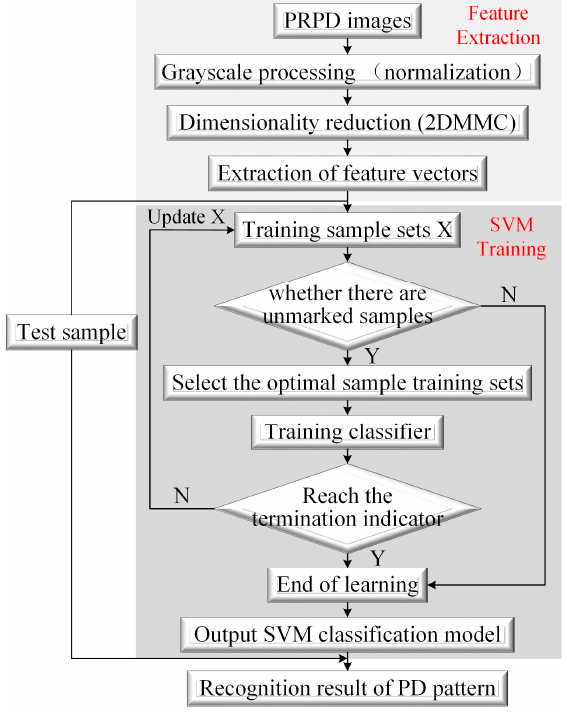
Figure 20. PD pattern recognition process based on an SVM.